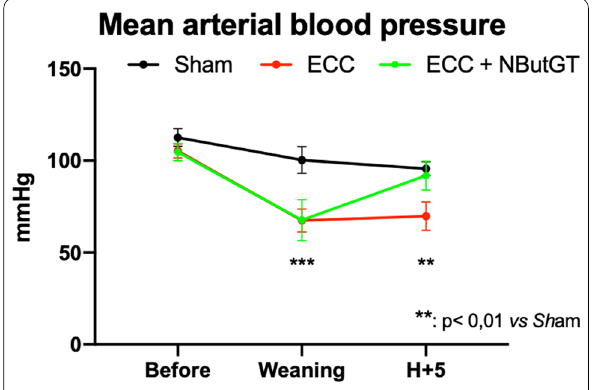
Figure 1: Impact of treatment with NbutGT in rat model of ECC: Mean arterial pressure before ECC, at weaning and at H Weaning. Values are presented as mean Determined by two ways ANOVA